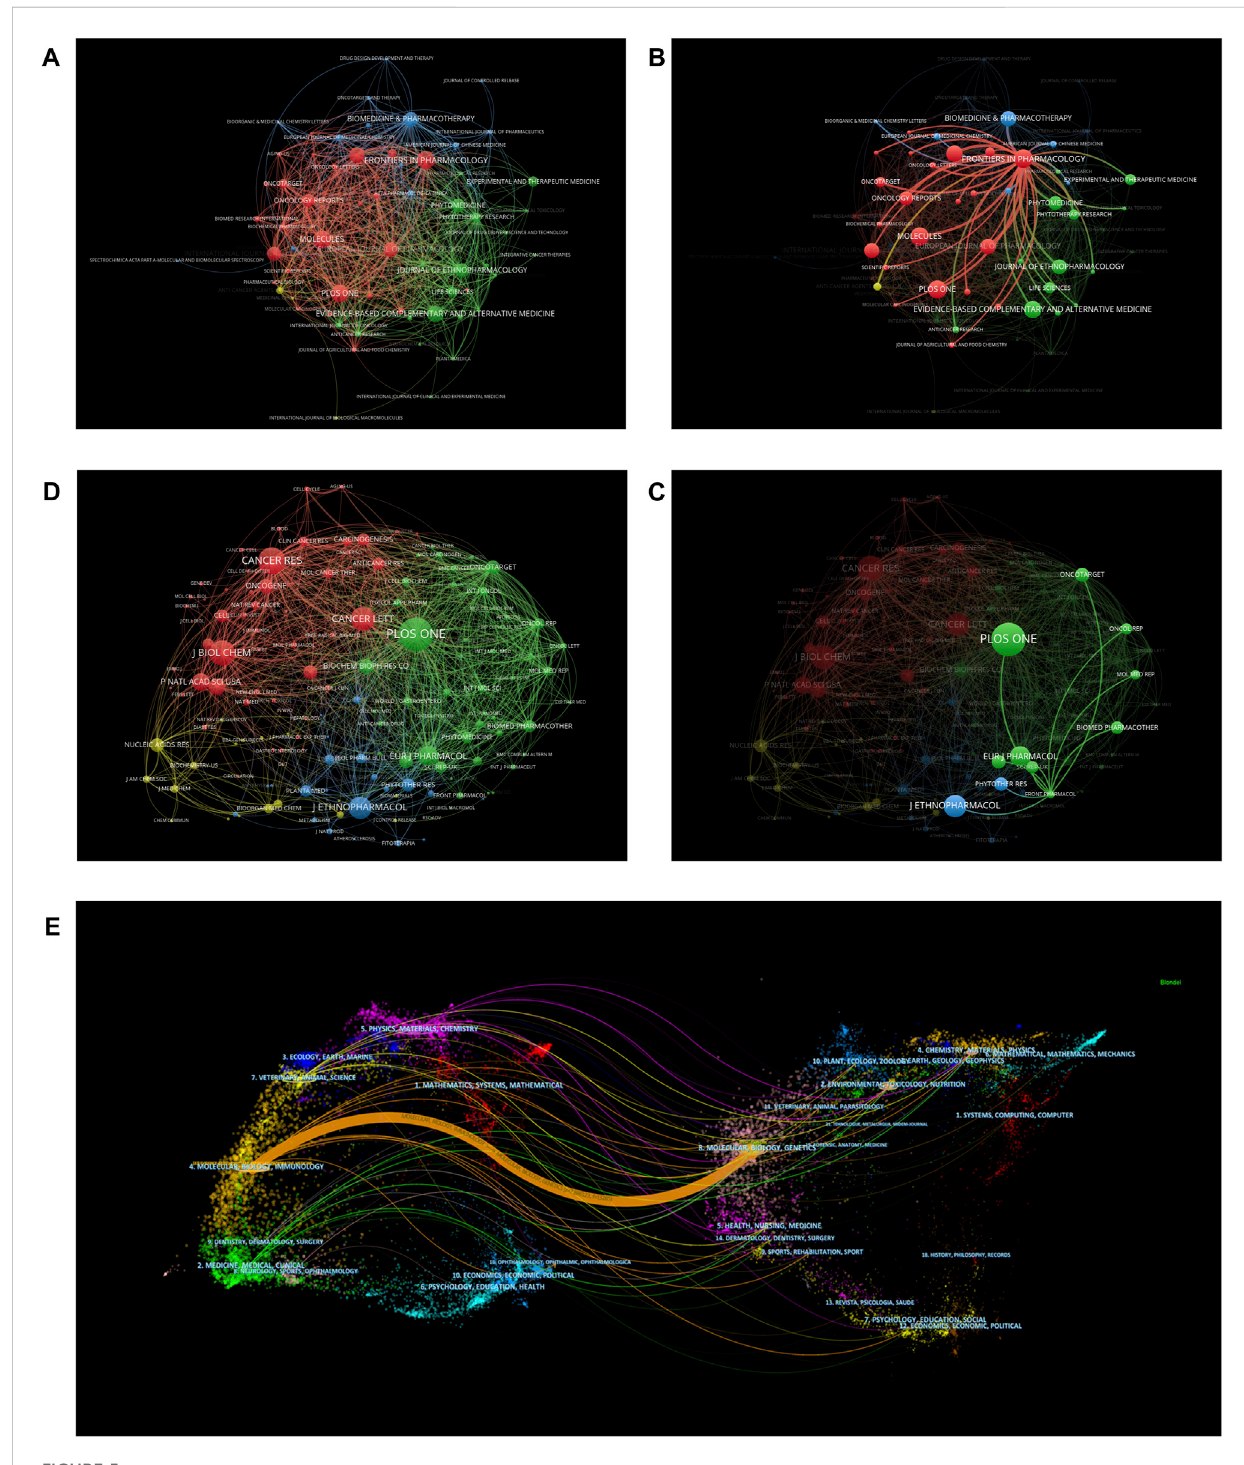
FIGURE 5 Theco-citedmapofjournals. (A,B) Themapofjournalsthat publishedpapers aboutberberineandtumor. (C,D) Themapofthecitedjournalsbased on Vosviewer. (E) The dual-map overlay of